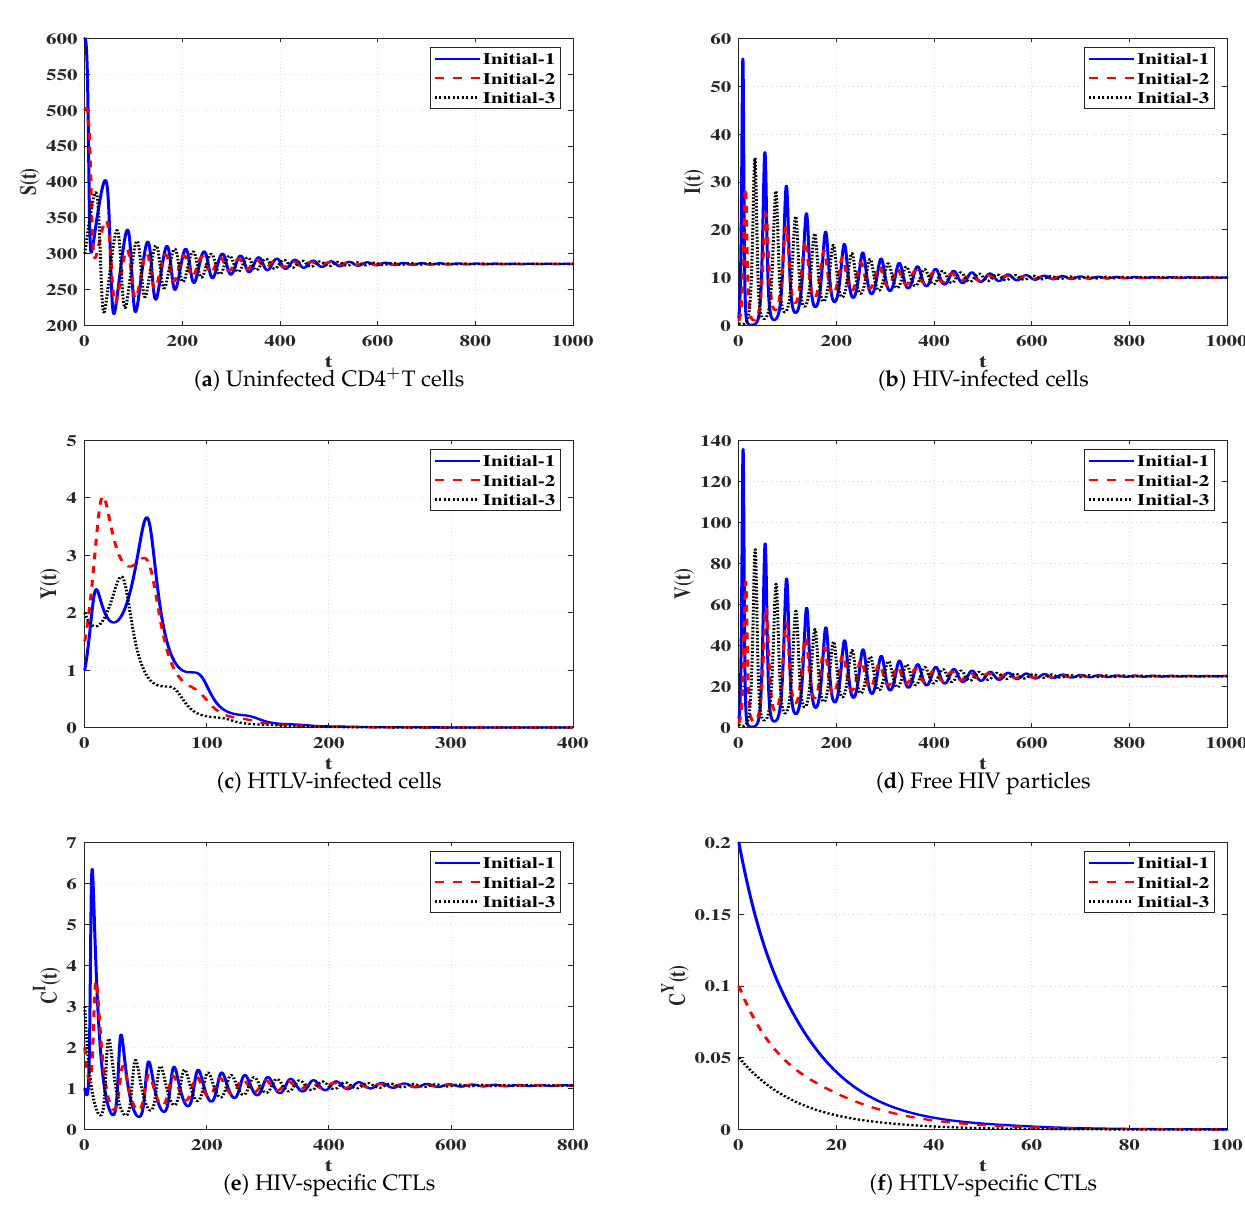
Figure 5. Solutions of system (4) when (cid:60) 3 > 1 and (cid:60) 5 ≤ 1. Set 7 (Stability of Ð 6 ) : η 1 = 0.0007, η 2 = 0.005, σ 1 = 0.005 and σ 2 = 0.1. We compute (cid:60) = 2.33 > 1, (cid:60) = 0.70 < 1 and (cid:60) (cid:60) = 1.43 > 1. Based on the conditions in 6 7 2 / 1 Table 1, the steady state Ð 6 = ( 285.72, 11.43, 1, 28.58, 0, 0.43 ) exists. In Figure 8, we plot the numerical solutions of the system and show that Ð 6 is G.A.S (Theorem 7). This situation leads to a persistent dual infection with HTLV and HIV where the HTLV-specific CTL is effective and the HIV-specific CTL does not